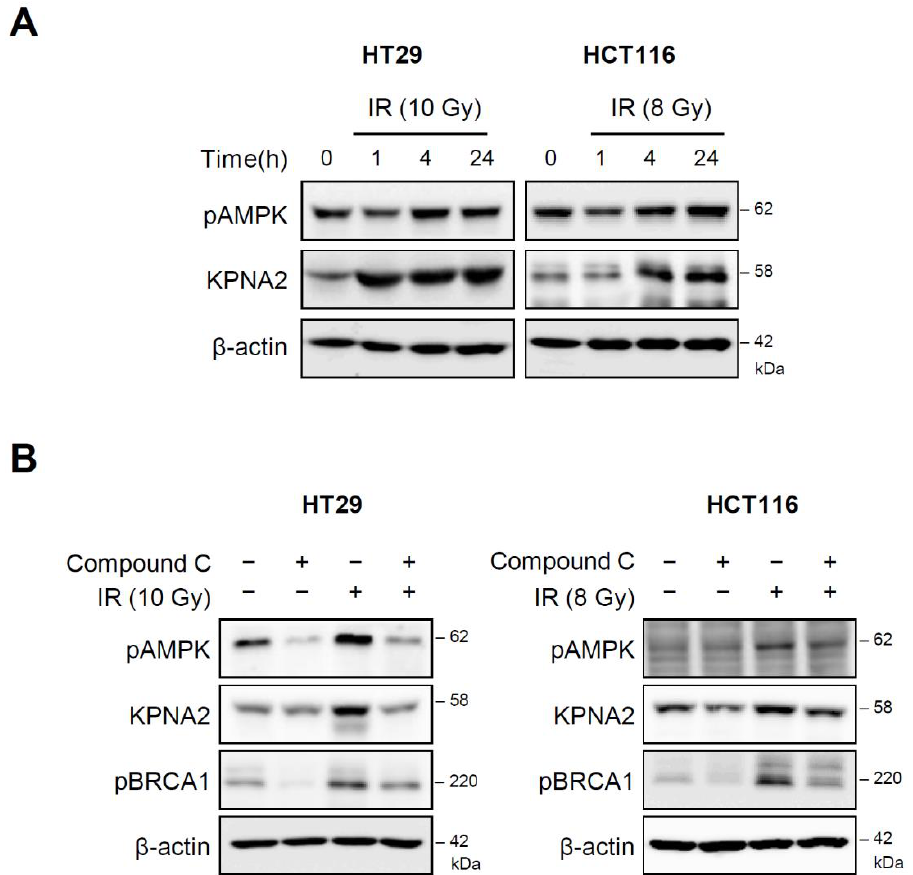
Figure 4. Radiation-induced AMPK regulates KPNA2. ( A ) The expression of pAMPK and KPNA2 in HT29 and HCT116 cells was measured by western blot analysis at the indicated times after IR. ( B ) HT29 and HCT116 cells were treated with an AMPK inhibitor, Compound C (10 μ M), for 1 h prior to IR. After further incubation for 8 h, the levels of indicated proteins were analyzed by western blotting. Results are representative of three independent